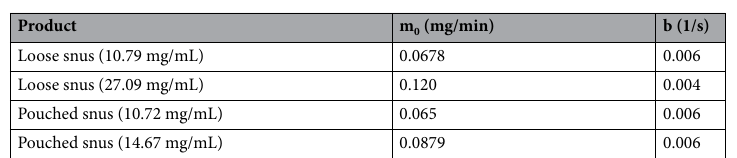
Table 3. Constants for the rate of nicotine release in the BC during the 60 min use time matching data of Digard et al. 37 : m = m 0 e −bt . m 0 rate of nicotine release at time 0, b rate constant, t time.